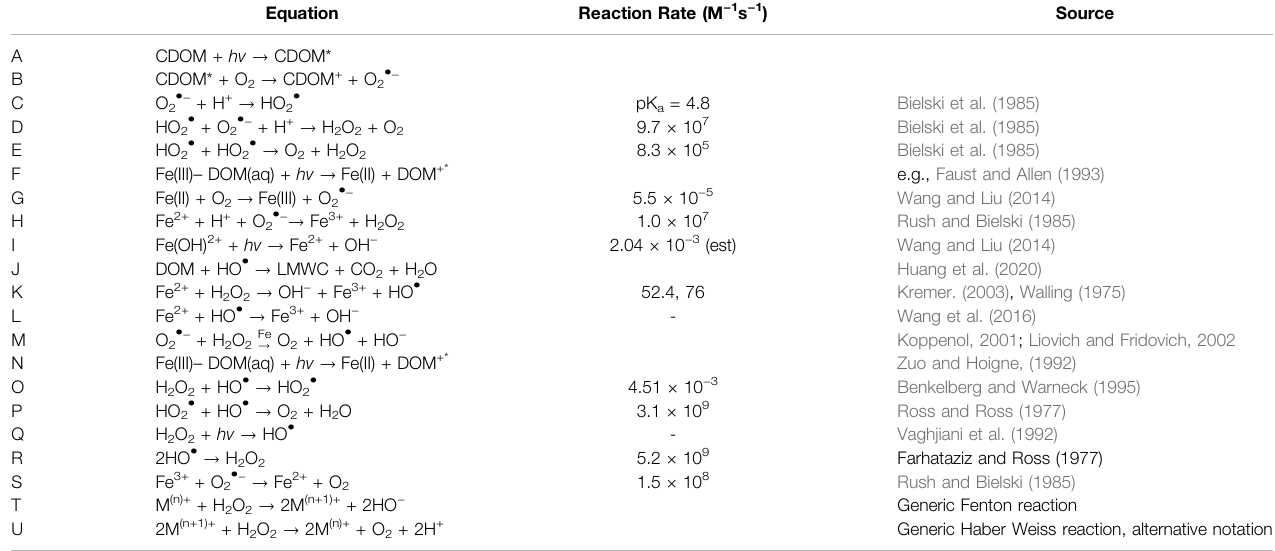
TABLE 1 | Reaction equations and rate constants for reactions in text and Figure 1 .